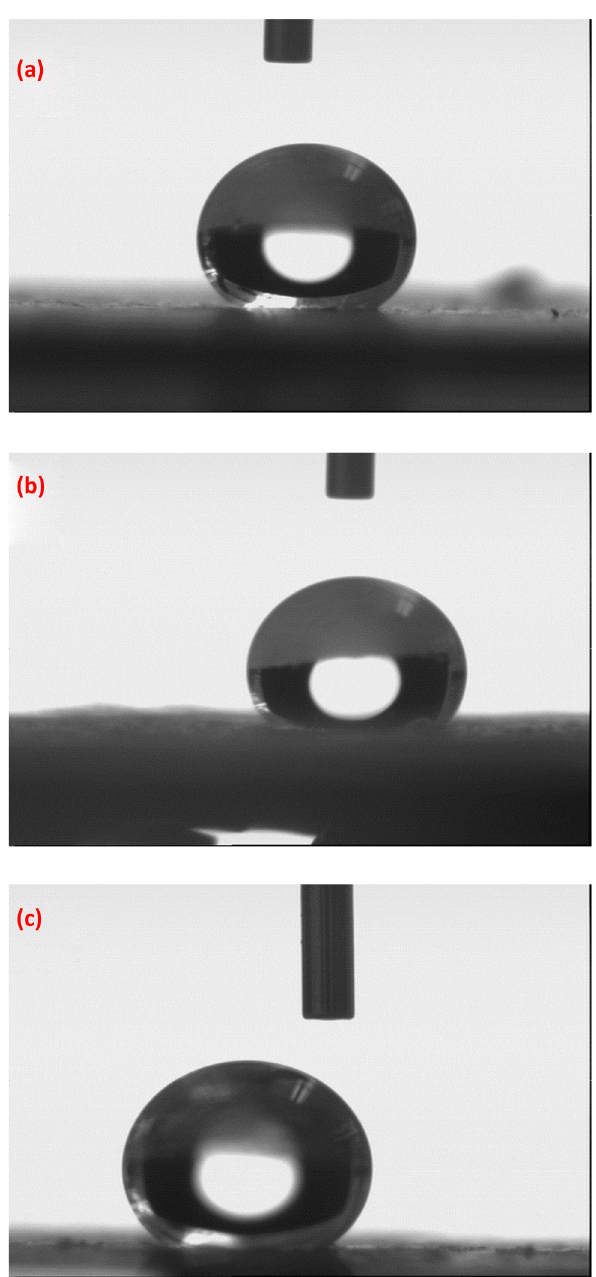
Figure 8: Representative pro fi les of water droplets on electrospun THV fi bers prepared from the following solutions: ( a ) sample 1: THV/ acetone 15 wt%: 15 cm_22 gauge_19 kV. ( b ) Sample 5: THV/acetone 15 wt% with THV:montmorillonite/ ( 10:1 ) 15 cm_16 gauge_19 kV. ( c ) Sample 3: THV/ethyl acetate 15 wt% 15 cm_16 gauge_19